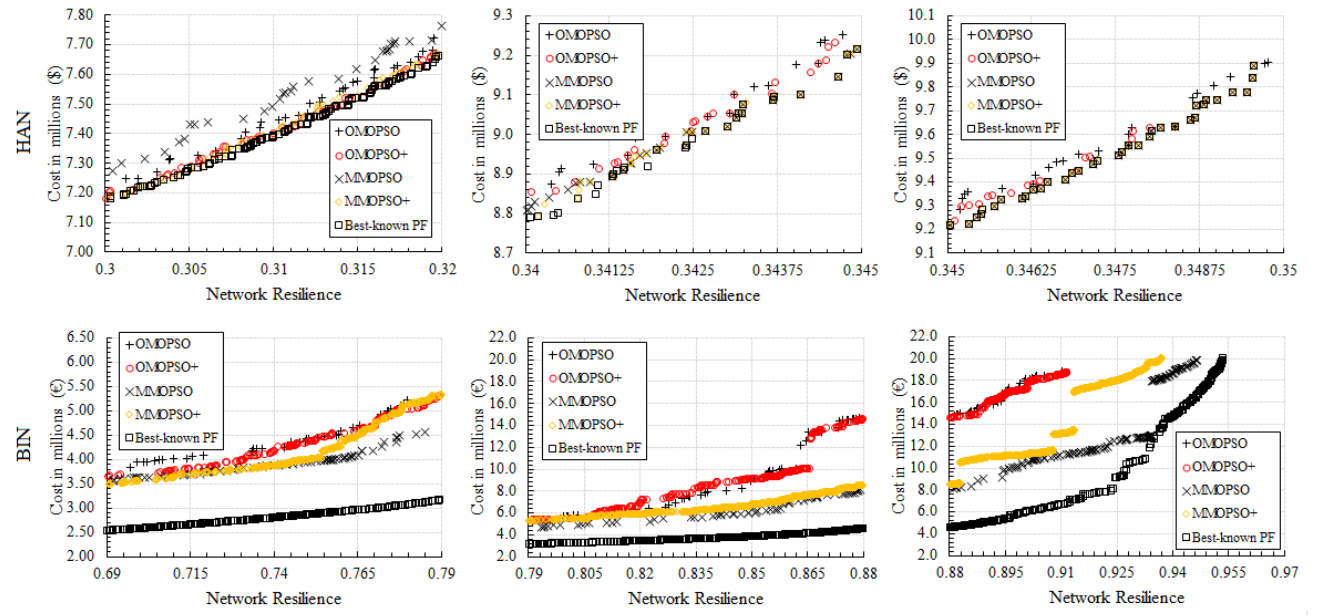
Figure 6. Comparison between the final approximate